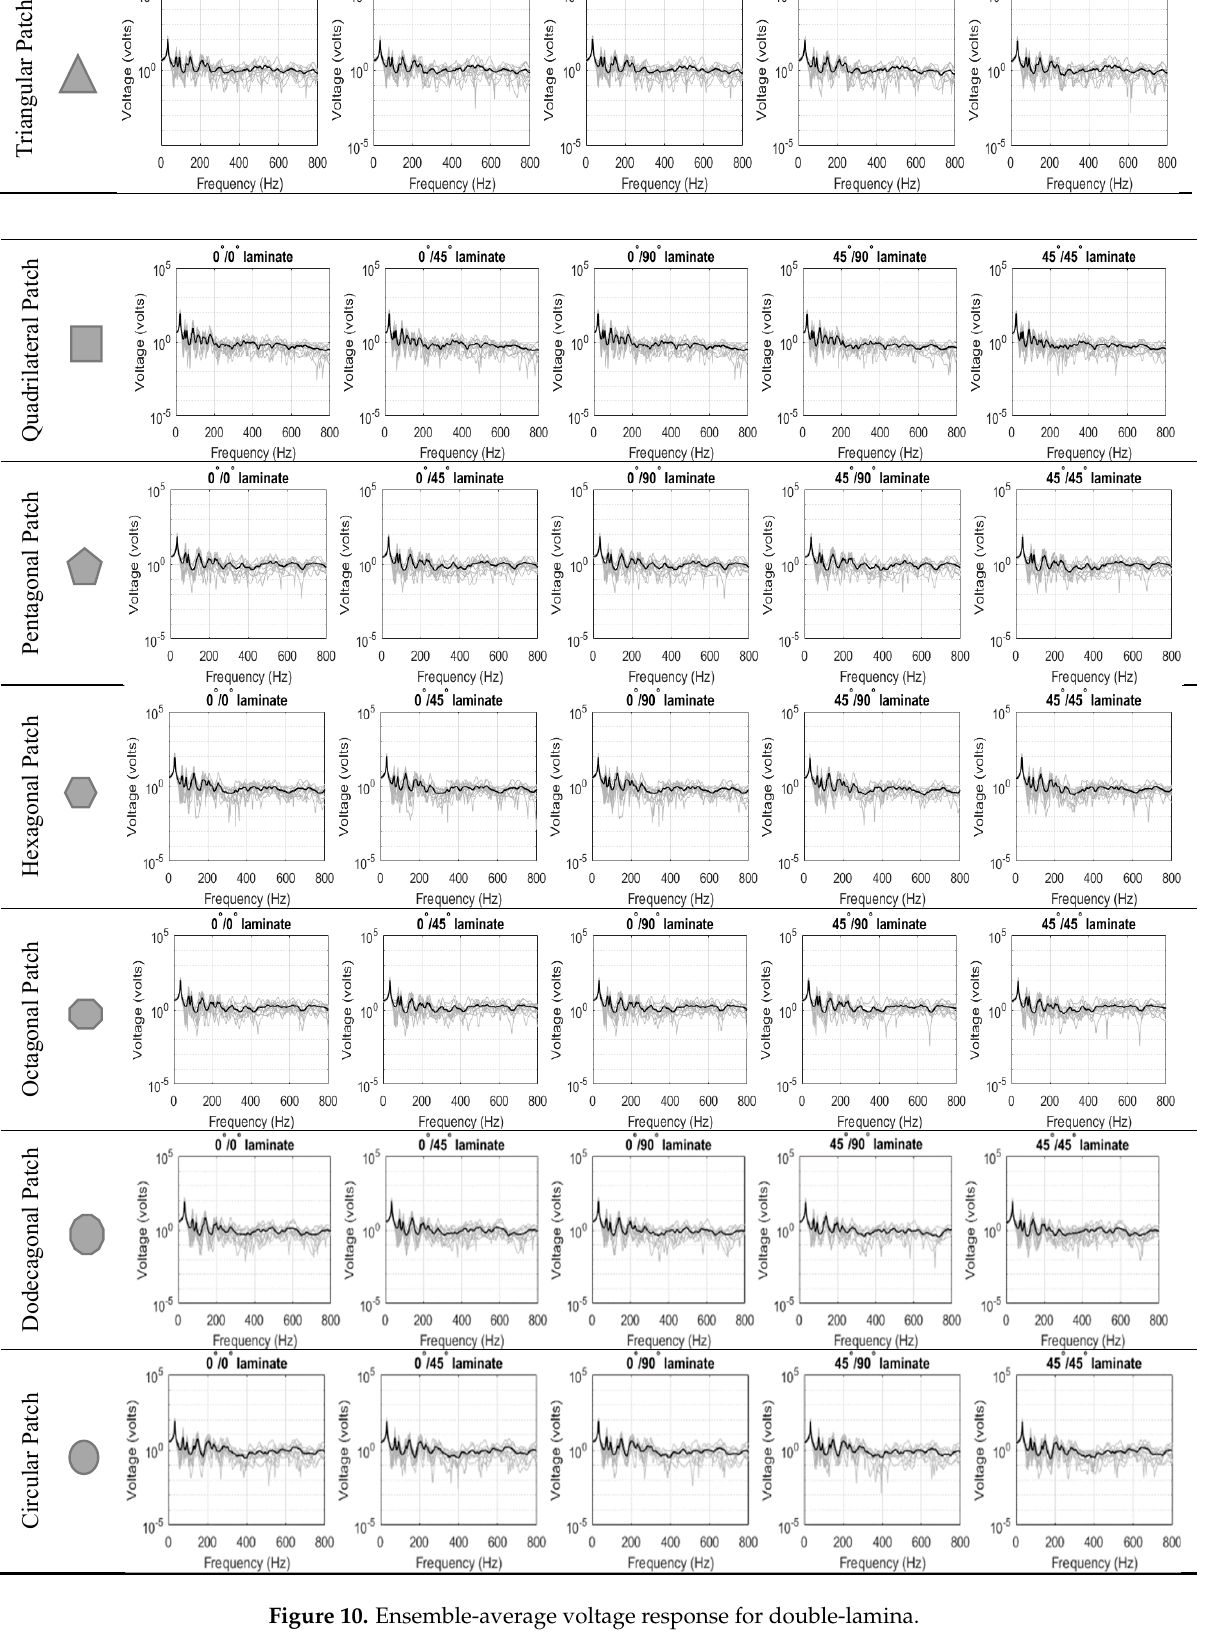
Figure 10. Ensemble-average voltage response for double-lamina.